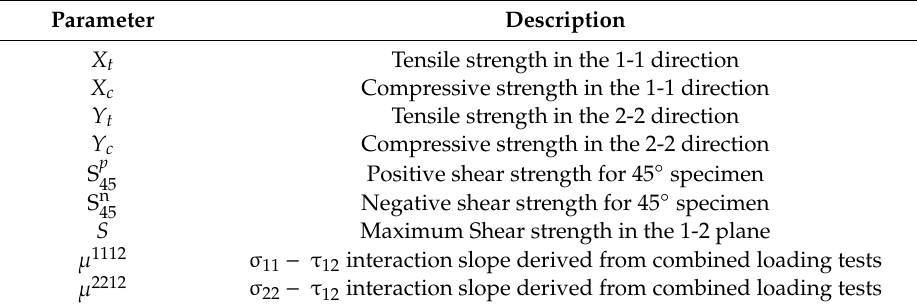
Table 2. Nomenclature of parameters used in the Osswald–Osswald